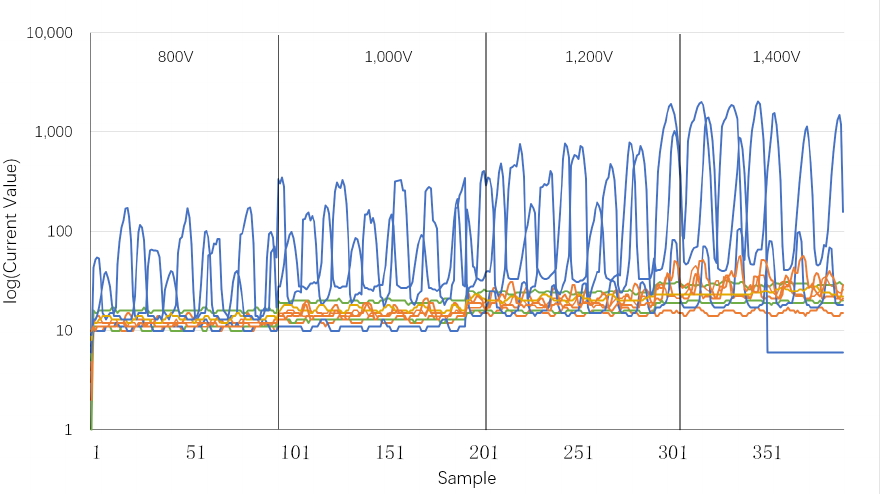
Figure 18. Current signal of the eggs in the voltage range of 800–1400 V. The current signals of 3 eggs with obvious cracks are set to blue, the current signals of 2 eggs with no cracks but obvious discharge are set to green, and the current of the eggs without discharge signal is set to